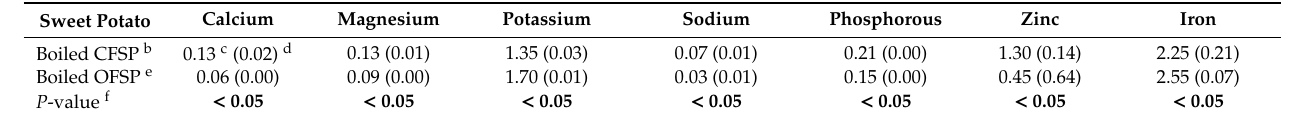
Table 8. Concentration of individual mineral elements of cooked sweet potato (mg / 100 g, DW a ). Sweet Potato